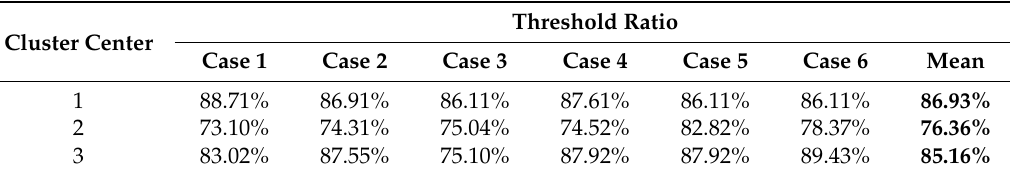
Table 7. Threshold ratios calculated for the cluster centers.